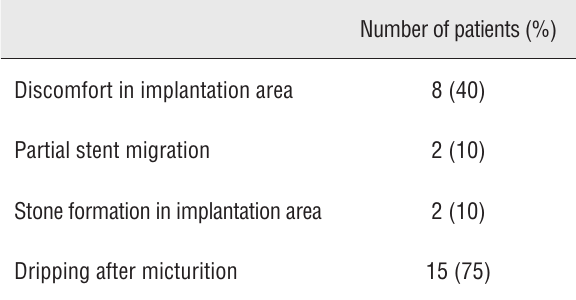
Number of patients (%)